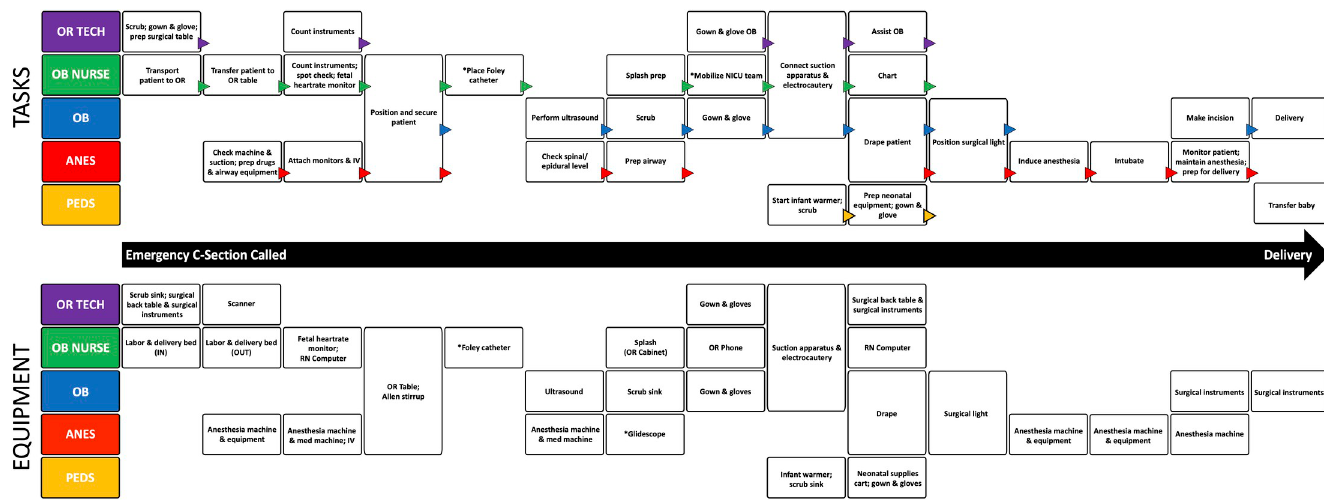
Fig 2. Task and equipment timeline for an emergency